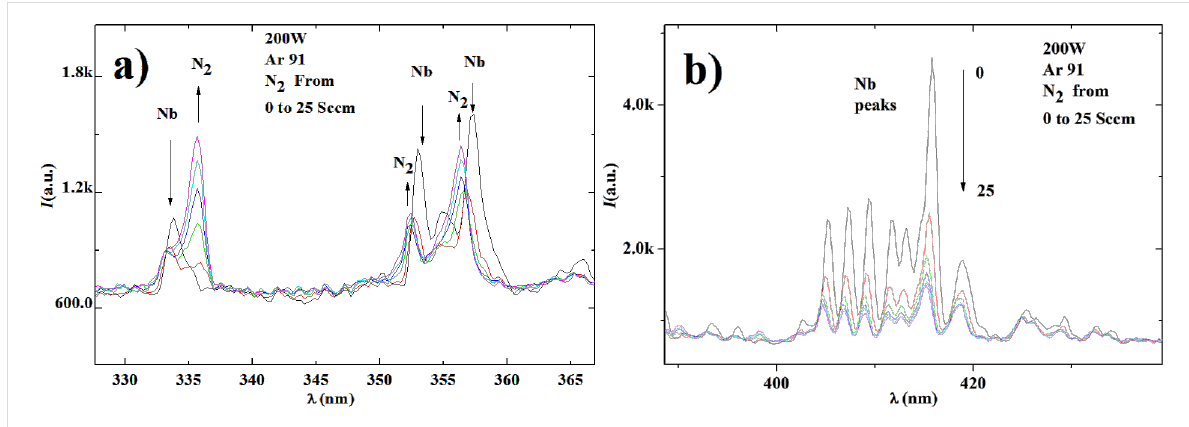
Figure 1: a) Glow-discharge peak intensity monitored in the region of 328–367 nm, an energy region in which we find both Nb and N 2 peaks. In the inset the power, the fixed Ar concentration and the range of the amount of N 2 are reported. The color of the six curves, obtained for increasing values of the N 2 flux, starting from 0 and going up to 25 sccm in steps of 5 sccm are as follows: black, red, green, dark blue, cyan, and magenta; b) Glow-dis- charge peak intensity in the region 388–438 nm, inset as in panel